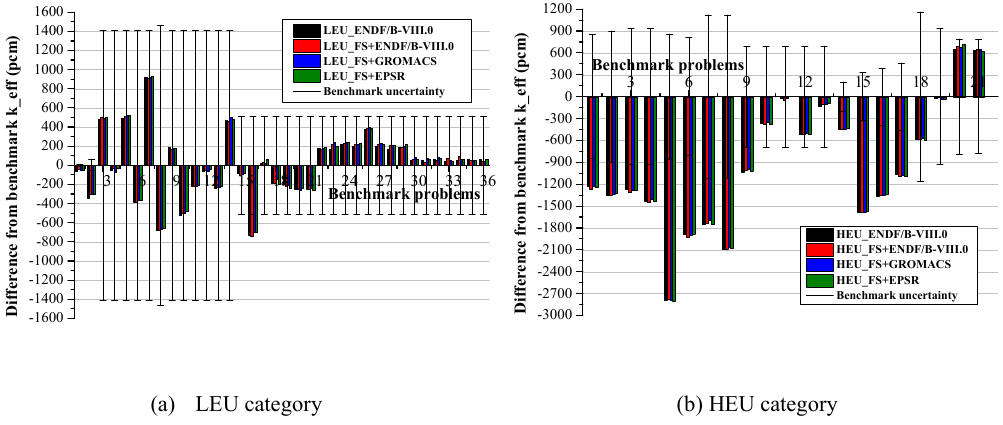
Fig. 4. Differences in the k eff calculated from the benchmark k eff and the thermal scattering libraries of the LEU and HEU categories.